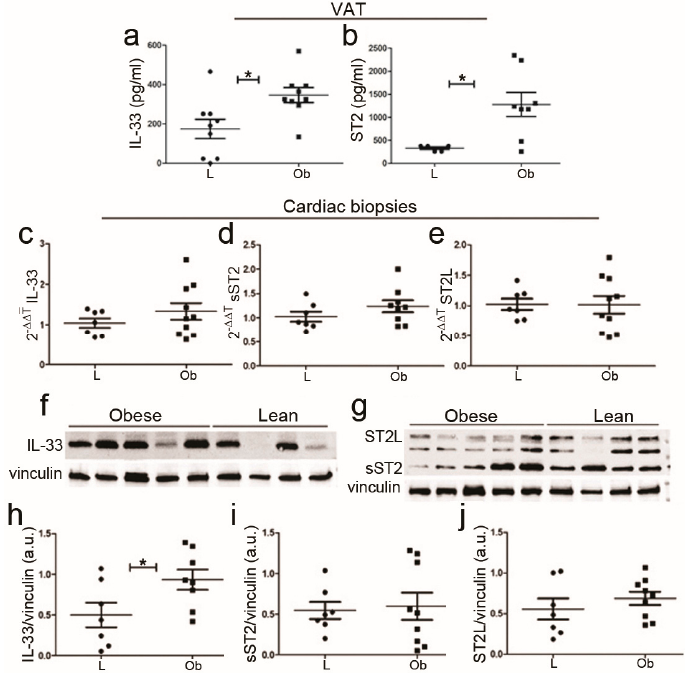
Figure 2. IL-33/ST2 expression in VAT tissue and cardiac biopsies of ZF rats. Graphs showed up- regulation of IL-33 ( a , b ) ST2 expression in visceral adipose tissue (VAT). Following qPCR experiments ( c – e ), graphs showed IL-33 , sST2 , and ST2L expression in cardiac biopsies. ( f , g ) Representative blots showed increased IL-33 protein and no difference in ST2 isoform levels (densitometric analysis ( h – j )). Student’s t -test: * p < 0.05. Full square stands for Obese rats, while full circle stands for Lean